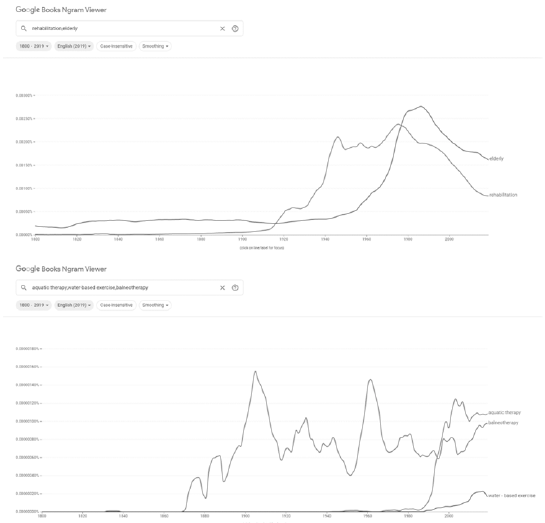
Figure 1. Graph of the frequency of the words: “rehabilitation” and “elderly” (up) and “aquatic therapy”, “water-based exercise” and “balneotherapy” (down) in the digitalized worldwide literature. The results were obtained by the Google Ngram Viewer application and they consider the entire production of works, including the non-scientific